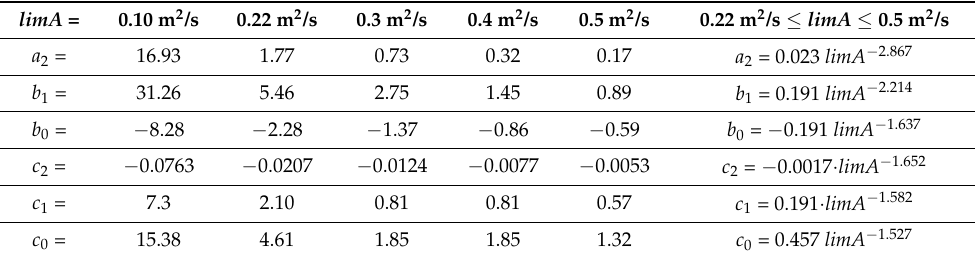
Table 2. Coefficients of the Q / L regression equation for criterion A.